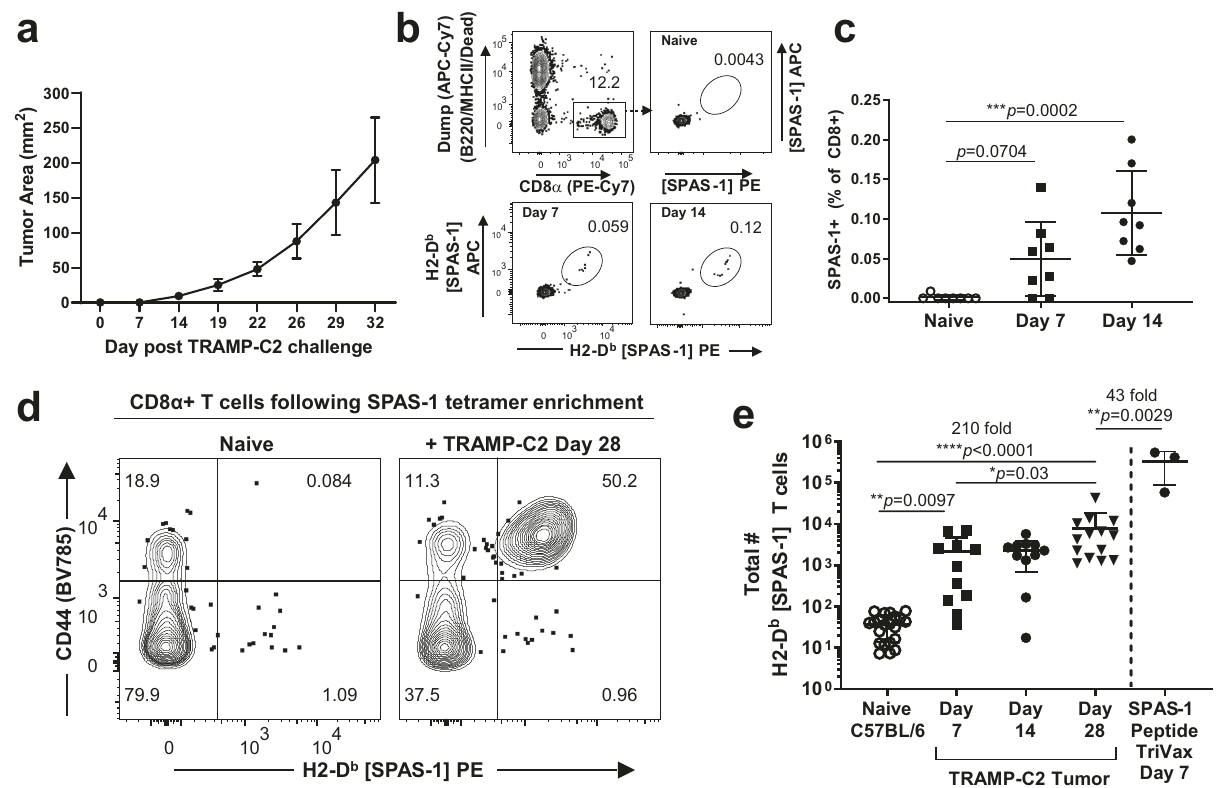
Fig. 1 Quanti fi cation of SPAS-1 neoantigen-speci fi c CD8 + T cells following TRAMP-C2 tumor challenge. a TRAMP-C2 cells were injected s.c. in the fl ank of C57BL/6J mice and tumor growth measured. Average of four mice from one representative experiment of four performed. b Representative fl ow cytometry staining of blood collected from mice before (naive) and at the indicated times after TRAMP-C2 tumor challenge. SPAS-1 + T cells within the CD8 + T cell gate were identi fi ed by dual staining with phycoerythrin (PE)- and allophycocanin (APC)- labeled peptide-MHC-I tetramers loaded with STHVNHLHC peptide speci fi c for the H8 neoantigen of SPAS-1 in TRAMP-C2 cells. c Quanti fi cation of staining shown in ( b ), compiled in multiple mice. Kruskal – Wallace test was performed, p = 0.0005, with exact p values by Dunn ’ s multiple comparision test; *** p < 0.001. Results in ( a – c ) are representative of four independent experiments performed. ( d , e ) Single-cell suspensions of pooled spleen and peripheral lymph nodes from naive tumor-bearing mice were incubated with PE- and APC- fl uorochrome tetramerized H2-D b SPAS-1. Tetramer-binding cells were captured by enrichment over anti- fl urochrome magnetic beads and then stained for fl ow cytometry. d Representative fl ow cytometry staining of gated CD8 + T cells after tetramer enrichment